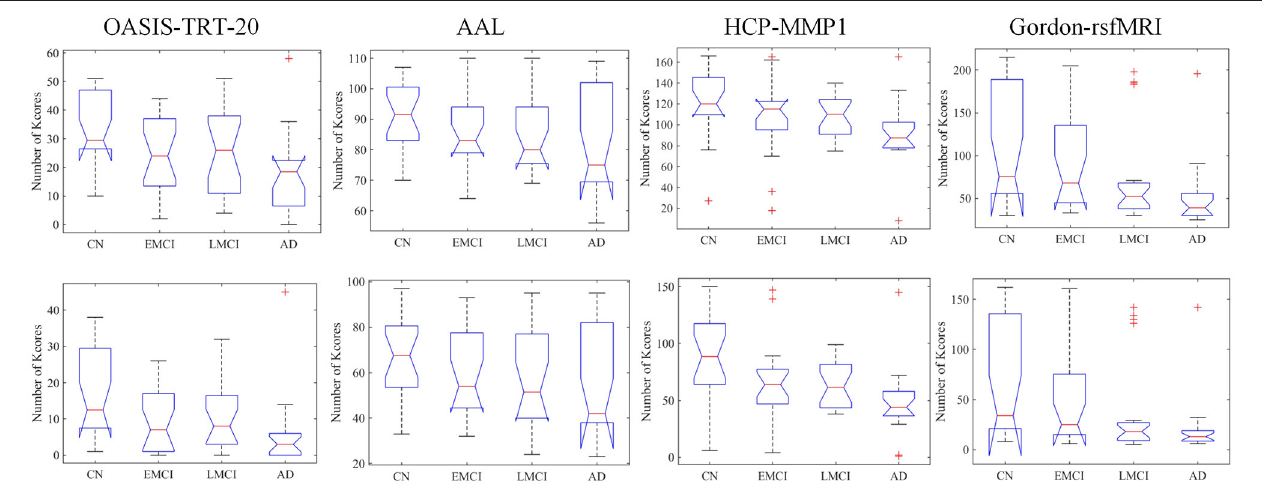
The significant p-values are shown in bold. OASIS, AAL, HCP, and Gordon represent OASIS-TRT-20 (62 regions), AAL (116 regions), HCP-MMP (180 regions), and Gordon- rsfMRI (333 regions), respectively.